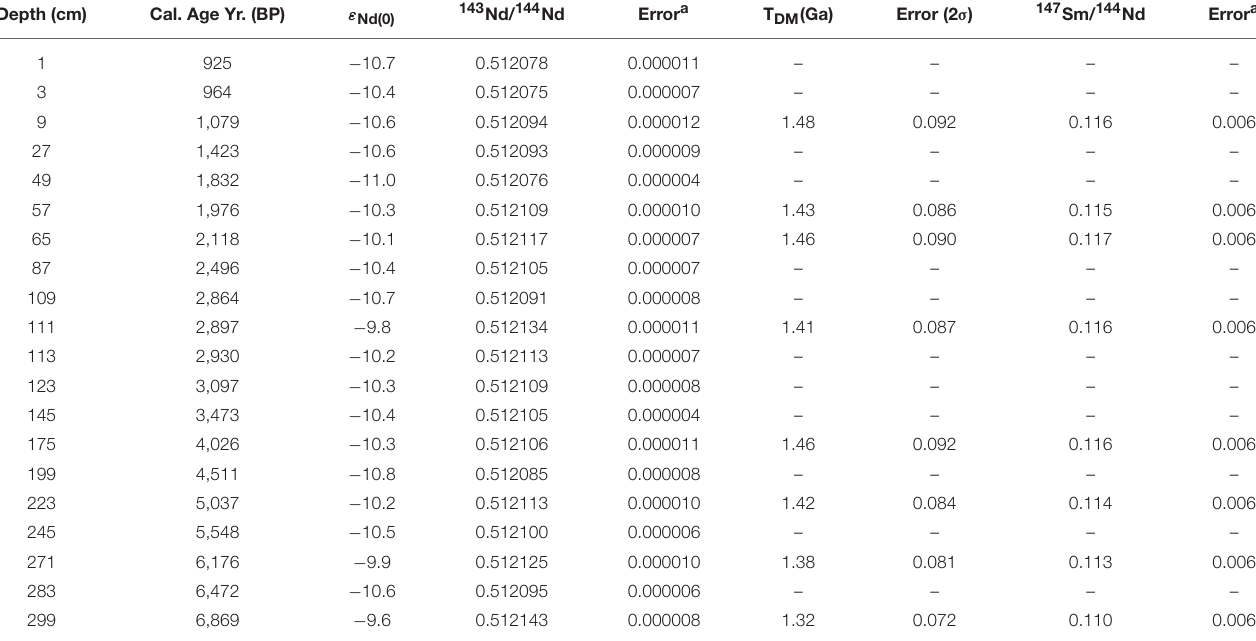
TABLE 1 | Nd systematics isotopic data of the Core 7616. Depth